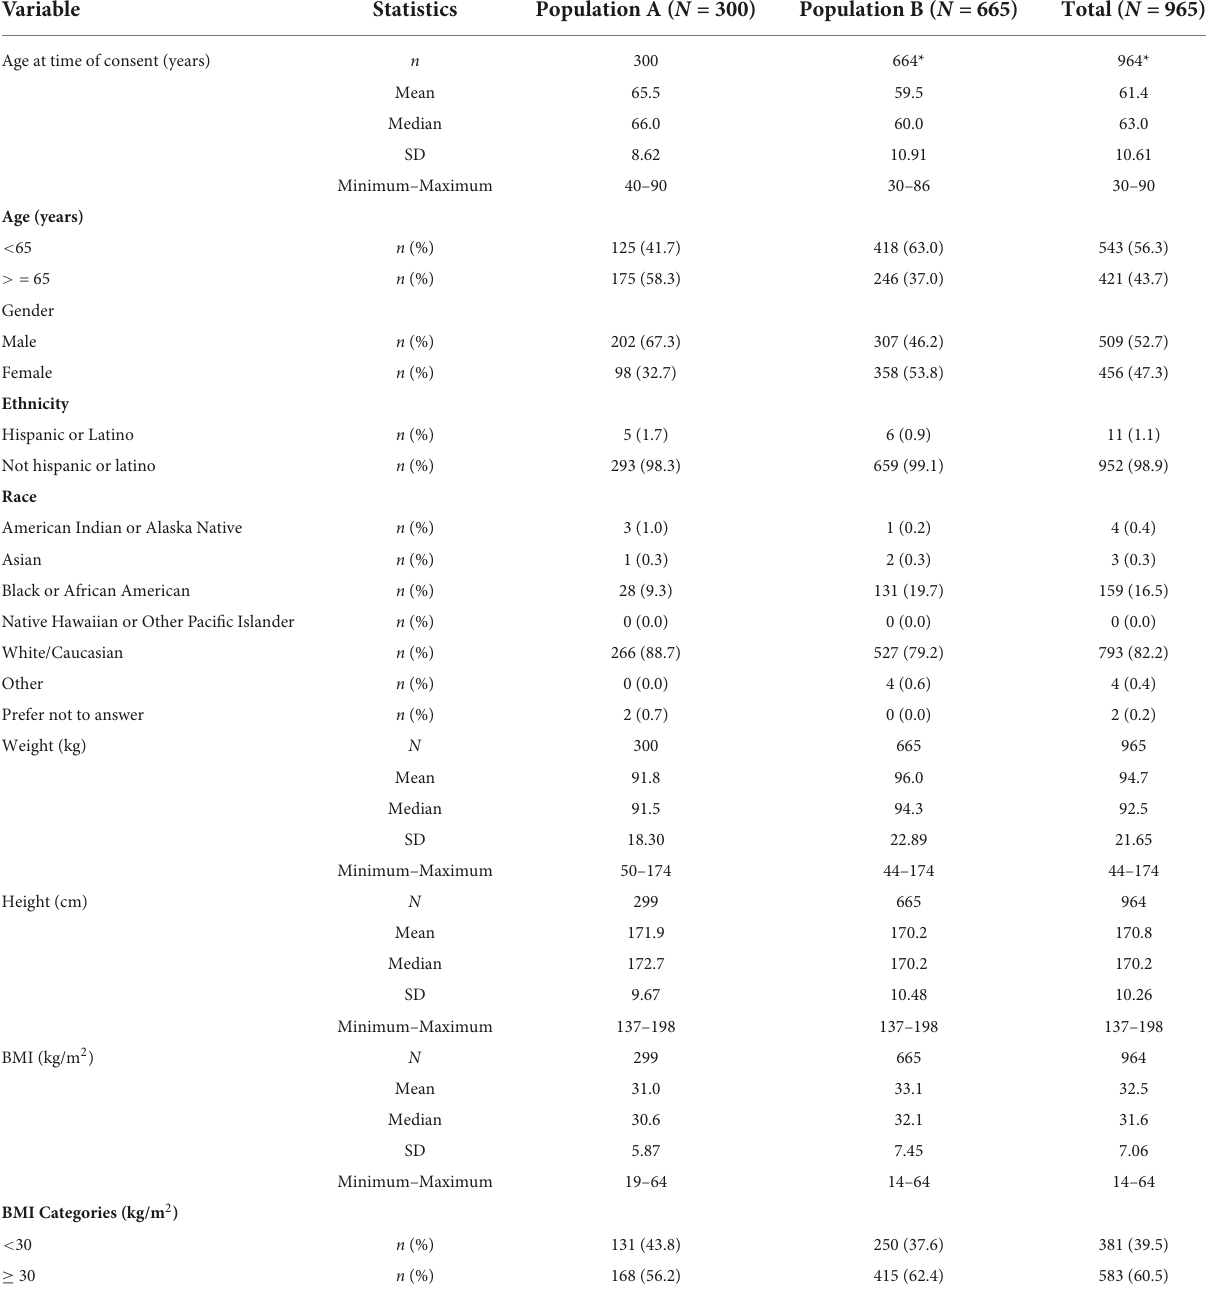
TABLE 4 Demographic breakdown of the validation populations A and